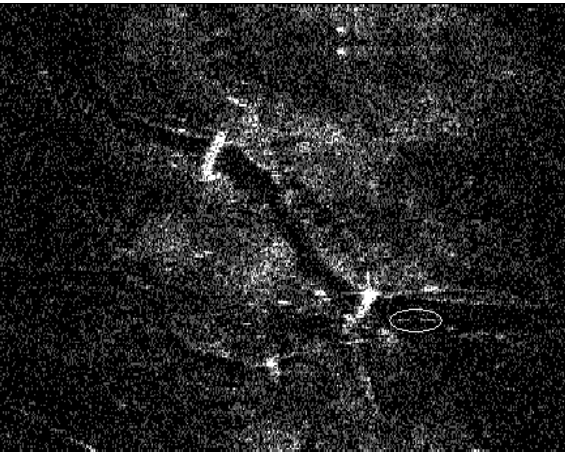
Figure 1. Small-scale oriented objects to be extracted